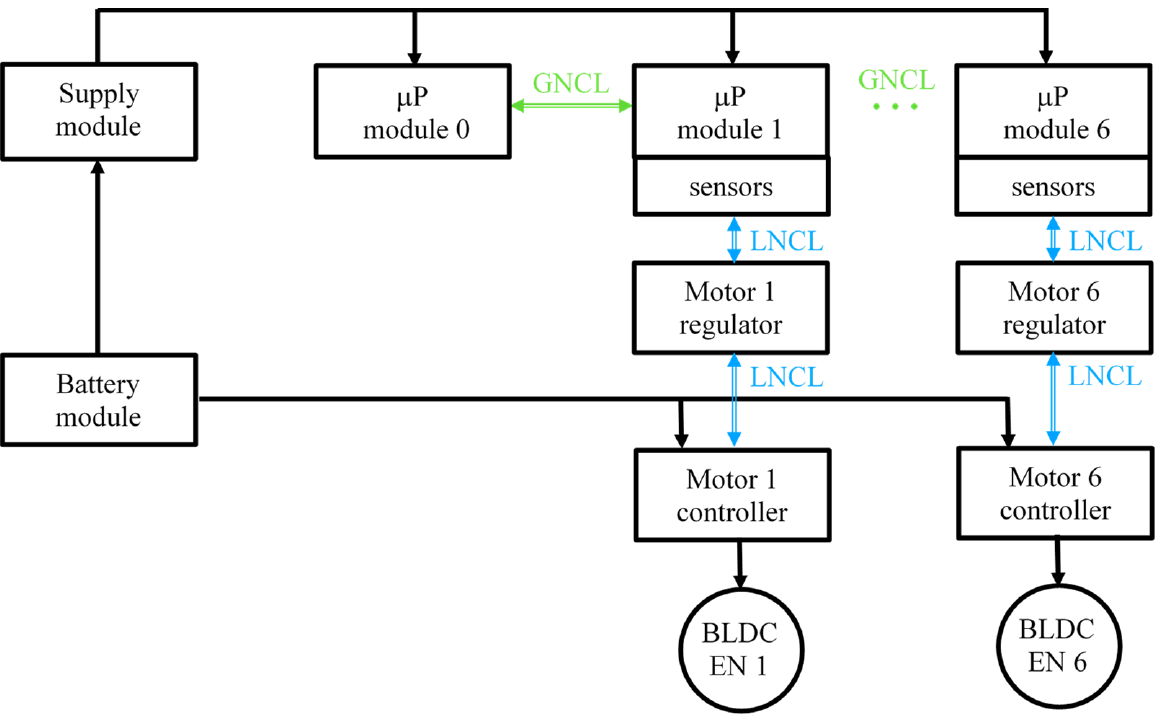
Figure 8. A structure of the six-joint exoskeleton control system.